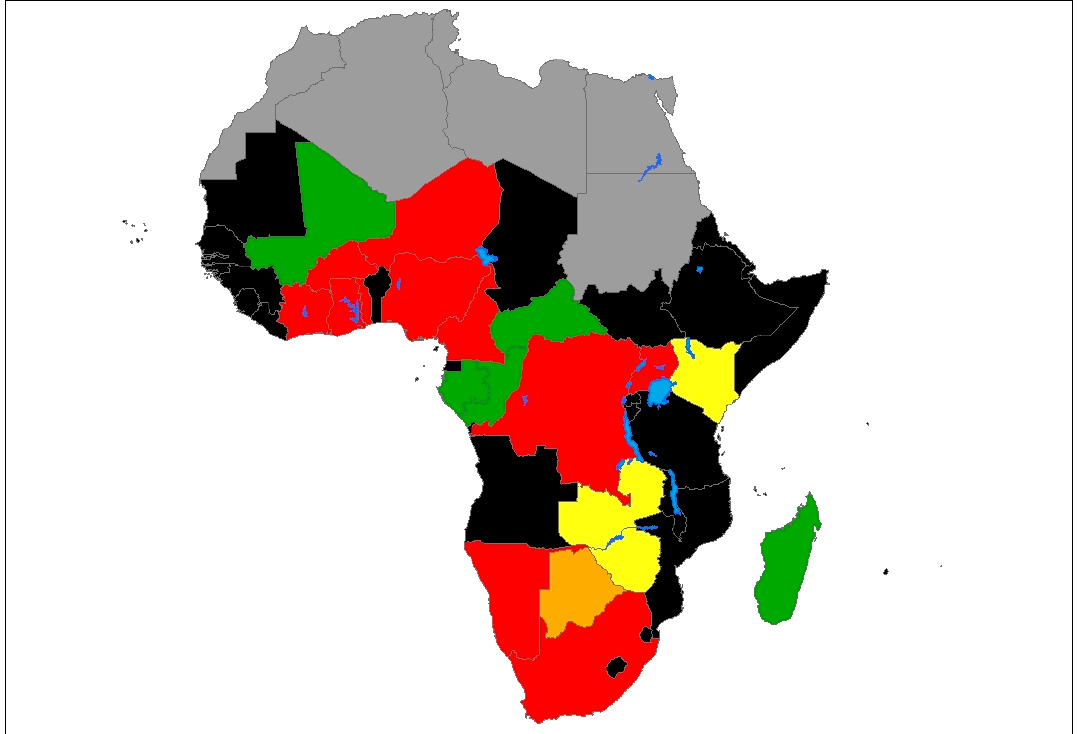
Figure 5. Geographical distribution of highly pathogenic avian influenza (HPAI) and low pathogenic avian influenza (LPAI) subtypes in sub-Saharan Africa. Color codes: red denotes countries reporting either HPAI only or both HPAI and LPAI; orange denotes countries reporting H5 or H7, but whose pathogenicity was not determined; yellow denotes countries reporting LPAI; green denotes countries reporting AIV whose subtypes and pathogenicity were not determined; black denotes countries in sub-Saharan Africa with no reports of AIV in birds in the study period; gray denotes North African countries not included in the study; blue denotes major water bodies. H9N2, H3N8, H5N2, H7N7 and H6N2 LPAI viruses were also detected in domestic poultry. For